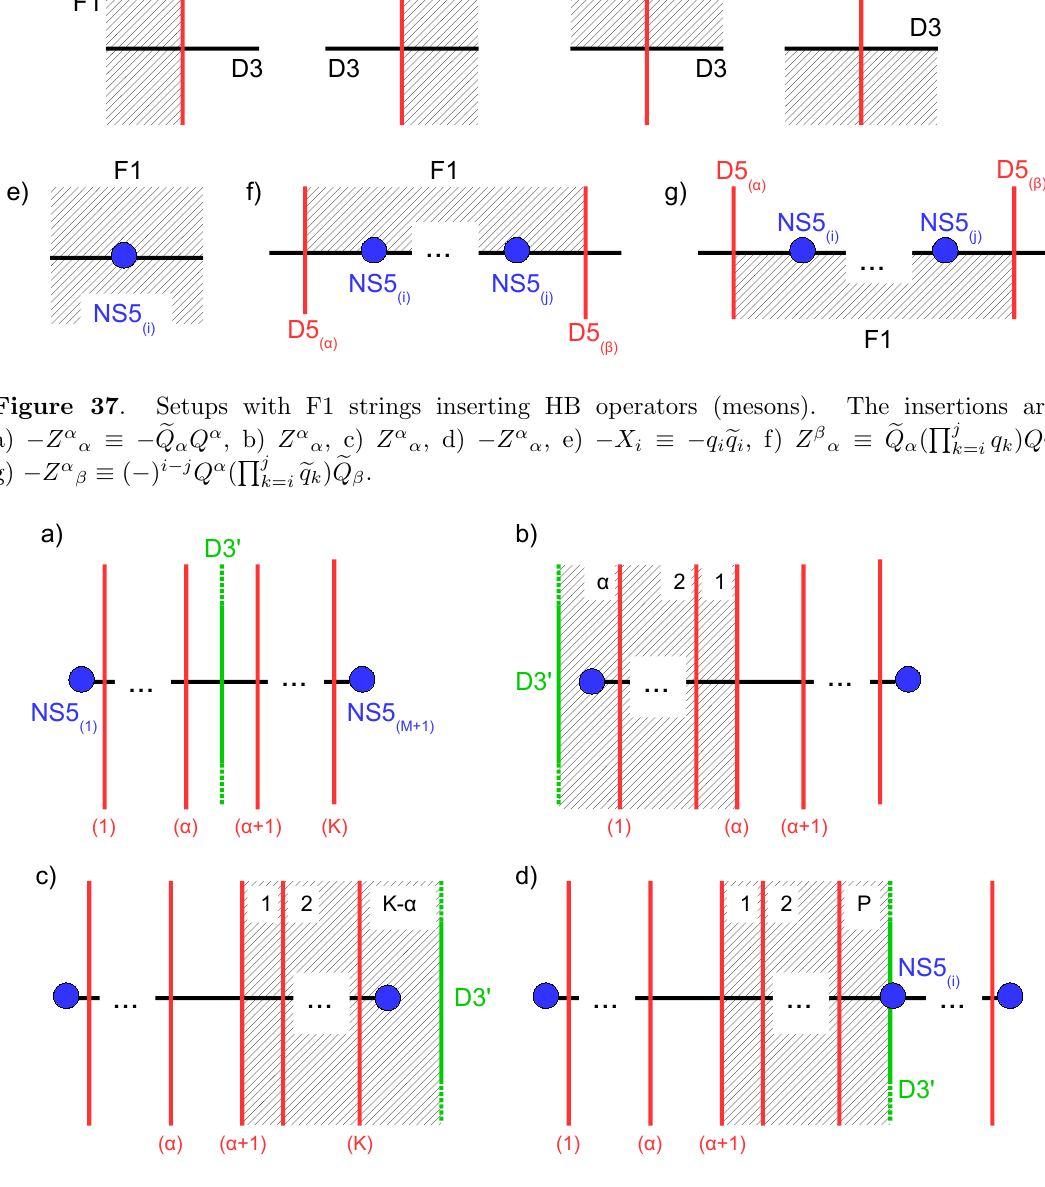
Figure 38 . Setups with D3’ branes inserting HB operators. The insertion of the (cid:12)gures a,b,c and d are related by HW D3’ move and insert the same operator Y (cid:11) (cid:17) (cid:24) 1 (cid:0) P (cid:11) Z (cid:13) (cid:13) = (cid:24) M +1 + (cid:13) =1 P K Z (cid:13) (cid:13) = (cid:24) i + X i + P (cid:11) + P Z (cid:13) (cid:13) (F-term constraints). (cid:13) = (cid:11) +1 (cid:13) = (cid:11) +1 combinations of complex scalars (cid:6) ( ’ (cid:0) ’ ) and the setup with D1 and D5 branes of i (cid:0) 1 i ( (cid:11) ) (cid:12)gure 40-e corresponds to the insertion of ( m (cid:0) ’ ), with m the complex mass of the (cid:11) i (cid:11) hyper-multiplet sourced by the